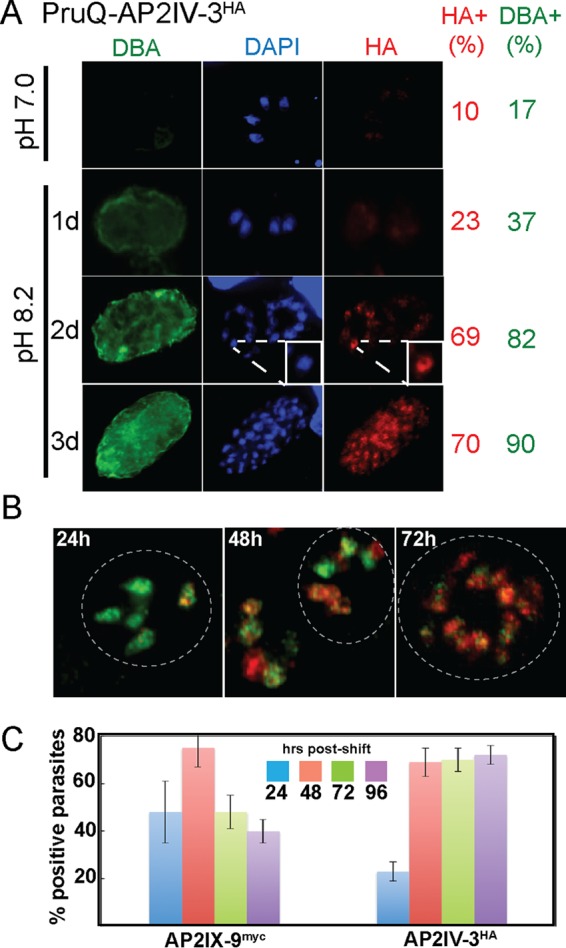
Toxoplasma AP2IV-3 is induced by stress during bradyzoite development. (A) The ApiAP2 factor AP2IV-3 was C-terminally epitope tagged by genetic knock-in at the endogenous locus with 3×HA in the PruQ strain. PruQ-AP2IV-3ha parasites were propagated in HFFs on coverslips with pH 7.0 or 8.2 medium. At various times, coverslips were fixed and costained with anti-HA antibody (red, AP2IV-3HA expression), biotin-labeled DBA (green, presence of cyst wall), and DAPI (blue, genomic DNA), followed by the appropriate secondary reagent (see Materials and Methods). The percentages of HA- and DBA-positive parasites in 100 randomly vacuoles were quantified (values on the right). The inset DAPI and anti-HA images of parasites at day 2 after a shift to pH 8.2 medium show colocalization, indicating that AP2IV-3HA was exclusively nuclear. (B, C) Utilizing sequential genetic knock-in at the endogenous loci in the PruQ parent strain, AP2IX-9 (3xmyc) and AP2IV-3 (3×HA) were C-terminally epitope tagged. IFA of the resulting dually tagged transgenic clone was performed with anti-HA (red stain) and anti-myc (green stain) MAbs. Representative vacuoles at 24, 48, and 72 h after an alkaline shift into pH 8.2 medium are shown in panel B. The dashed circles indicate vacuole boundaries. Triplicate quantitative analysis of AP2IX-9myc- and AP2IV-3HA-positive parasites in 100 randomly selected vacuoles across the 96-h alkaline-shift experiment was performed, and the results are graphed in panel C.